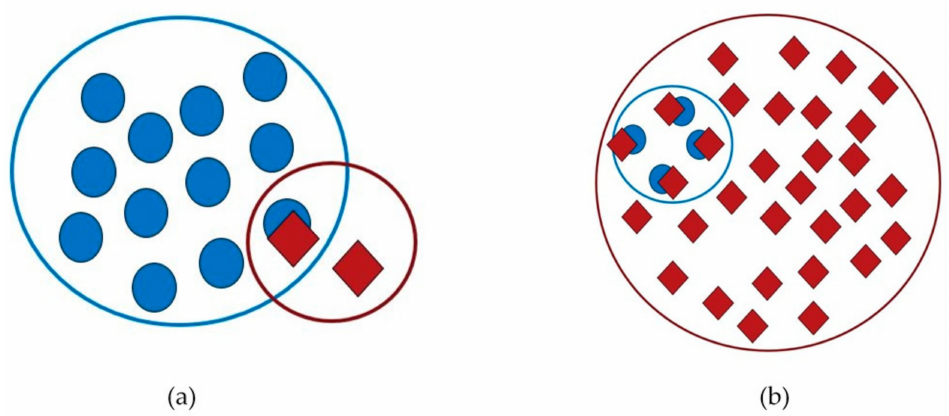
Figure 5. Blue is verified boulder points and red is predicted boulder points. ( a ) A 50% overlap of the predicted boulder points. ( b ) Less than 50% overlap of the predicted boulder